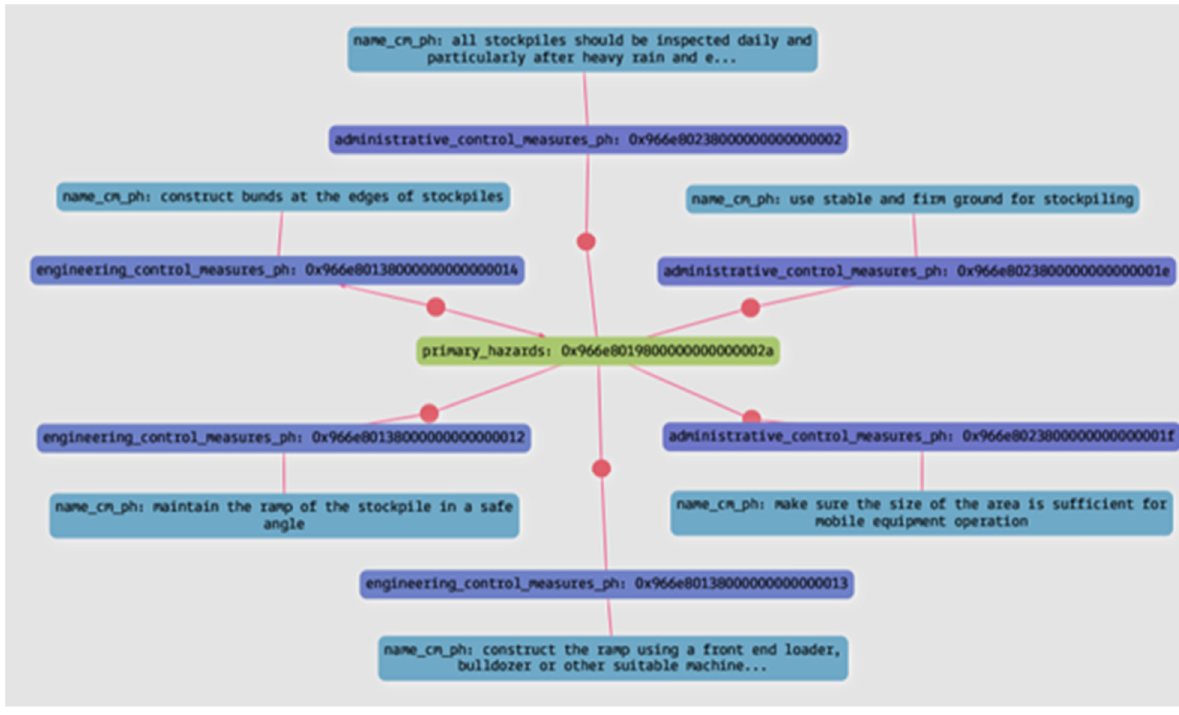
Figure 12. The result of Query 3, in a graph form.